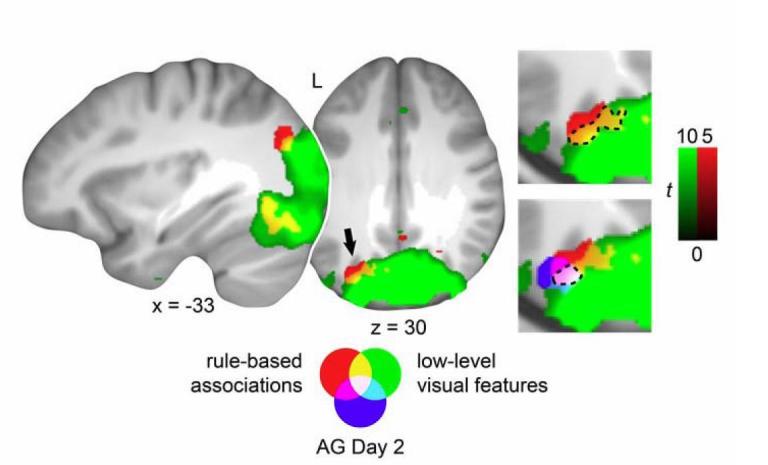
Generalization of schema component representations from day 2 to the transfer test.Multi-voxel patterns of rule-based associations and low-level visual features were shared across study phases. Cut-outs of the horizontal slice are magnified to appreciate the overlap of schema components. Blue depicts the left AG cluster showing overlap of schema component during day 2. For display purposes, all maps were resliced to a voxel dimension of 0.5 mm isotropic and are shown at P < 0.001, uncorrected Table 5 (updated manuscript). L – left. This figure is incorporated in updated Figure 8.